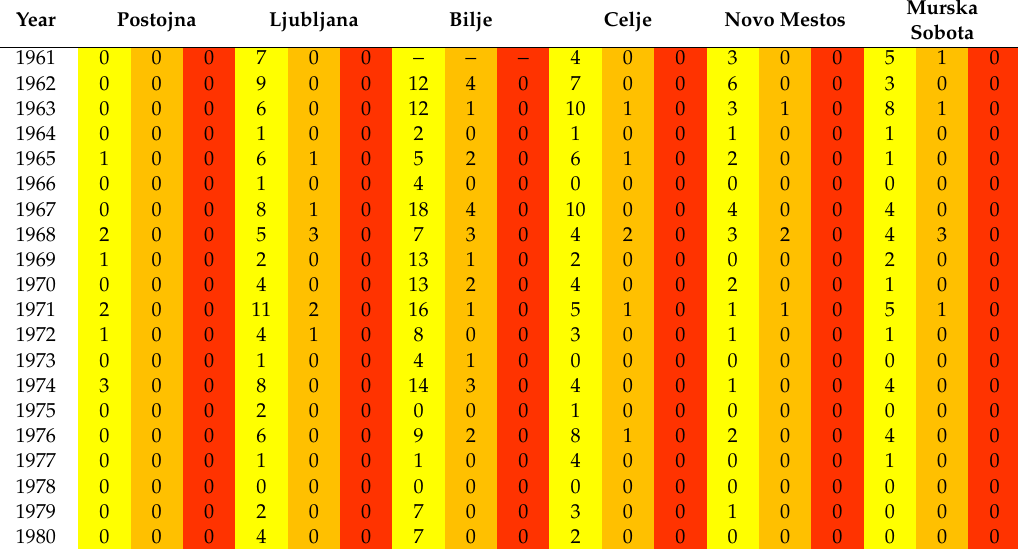
Table A1. The number of days in each summer from 1961 (in Bilje from 1962) to 2019 with fulfilled conditions for the yellow (first column, potentially dangerous), orange (second column, dangerous) or red (third column, very dangerous) meteoalarm at six locations in